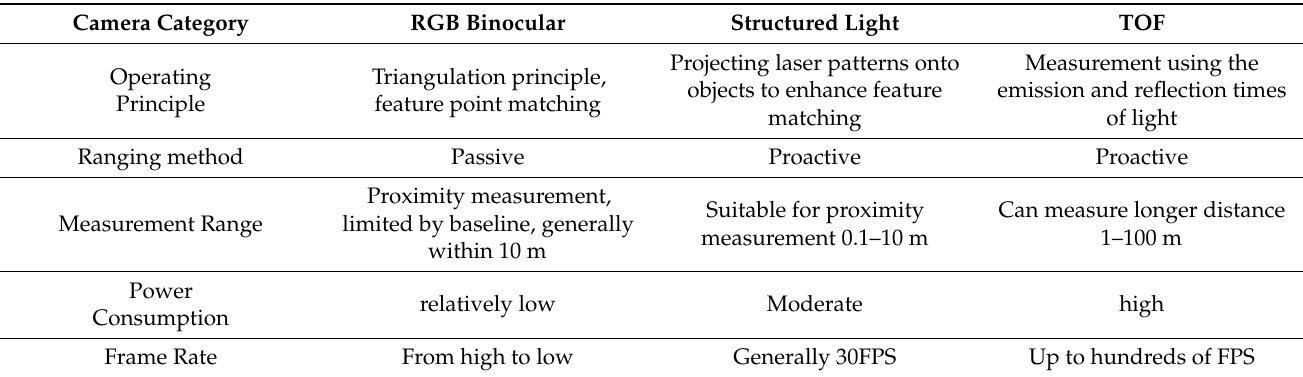
Table 1. Performance Comparison of Three Types of